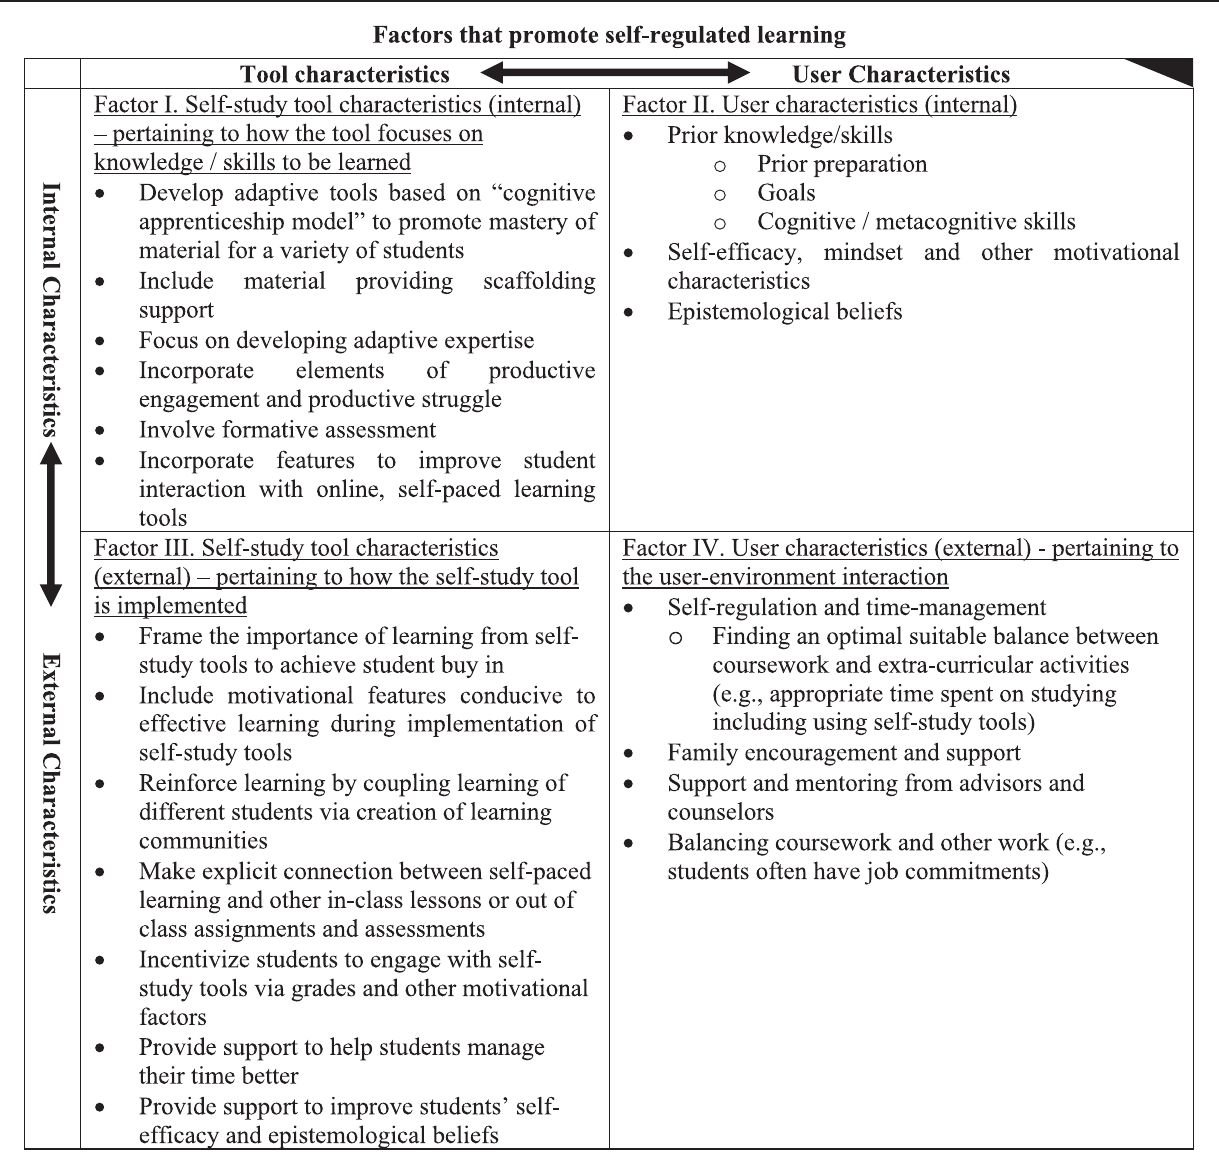
FIG. 5. Self-study for engaged learning framework